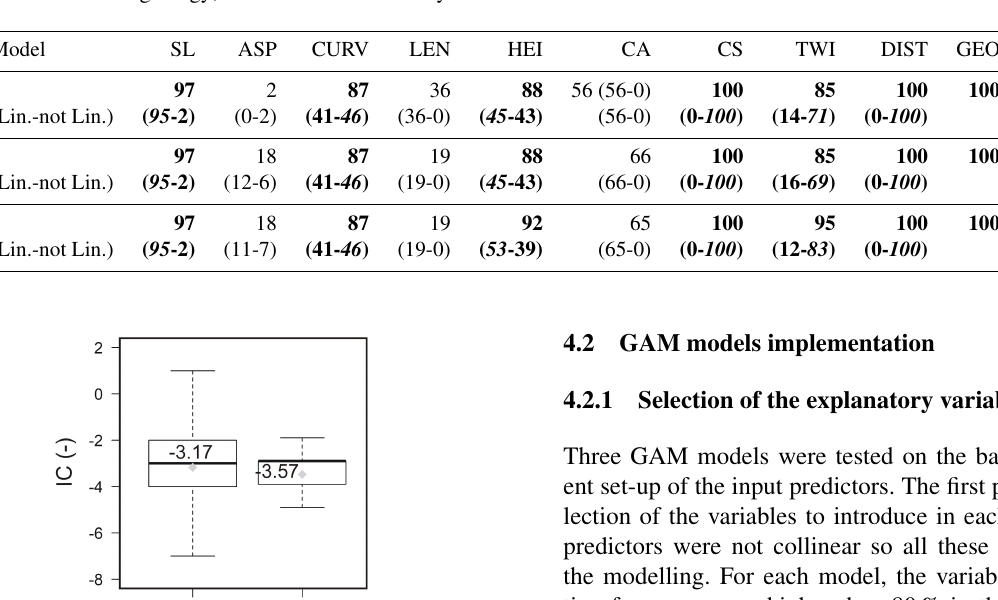
Table 2. Frequencies (in percentages) of explanatory variables (both linear and non-linear) selected by 100-fold bootstrap procedure. The explanatory variables selected by 100-fold bootstrap procedure with an absolute frequency greater or equal than 80% are highlighted in bold. In the brackets, the frequencies (in %) of selection of each variable as linear or non-linear is shown. The italic number corresponds to the frequency of the selected function connected to each variable. SL: slope angle; ASP: aspect; CURV: curvature; LEN: slope length; HEI: